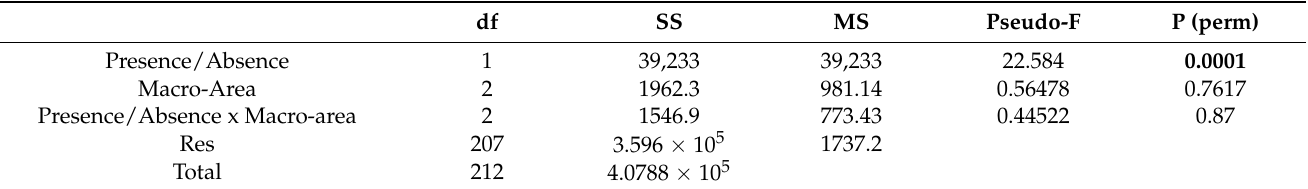
Table 2. PERMANOVA was performed on sea fan density of the sites where Astrospartus mediterraneus was found in the investigated period. Bray-Curtis similarity index used for the resemblance matrix construction; permutation n = 9999. Significant values are in bold.